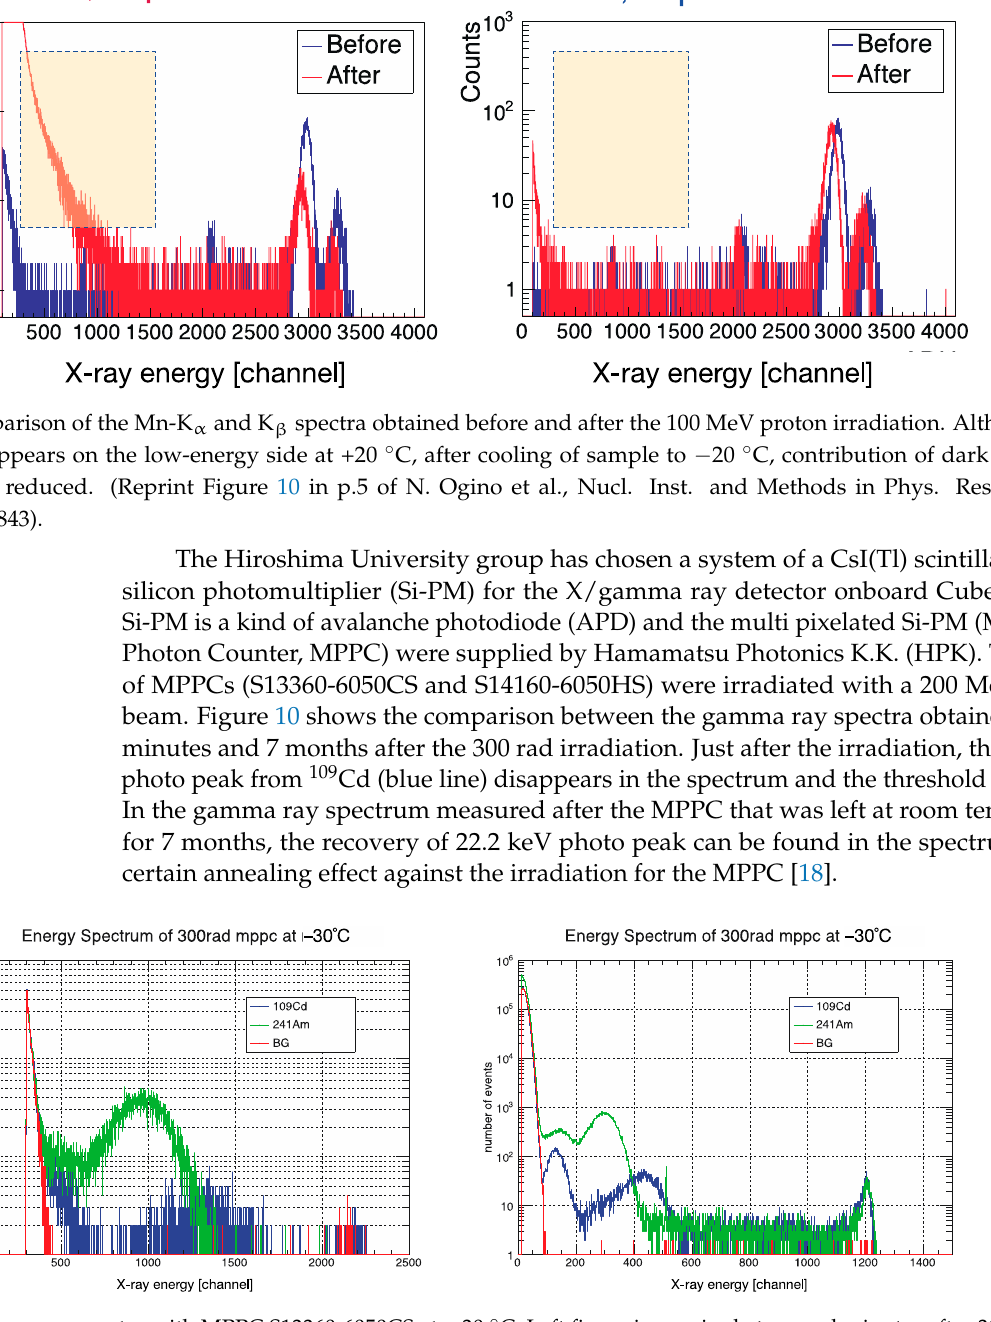
Figure 10. Gamma-ray spectra with MPPC S13360-6050CS at –30 ˚ C. Left figure is acquired at several minutes after 300 rad irradiation and right figure shows the spectra measured at 7 months after irradiation. (Reprint Figure 4 in p.3 of N. Hirade et al . , Nucl. Inst. and Meth. in Phys. Research A986(2021) 164673).